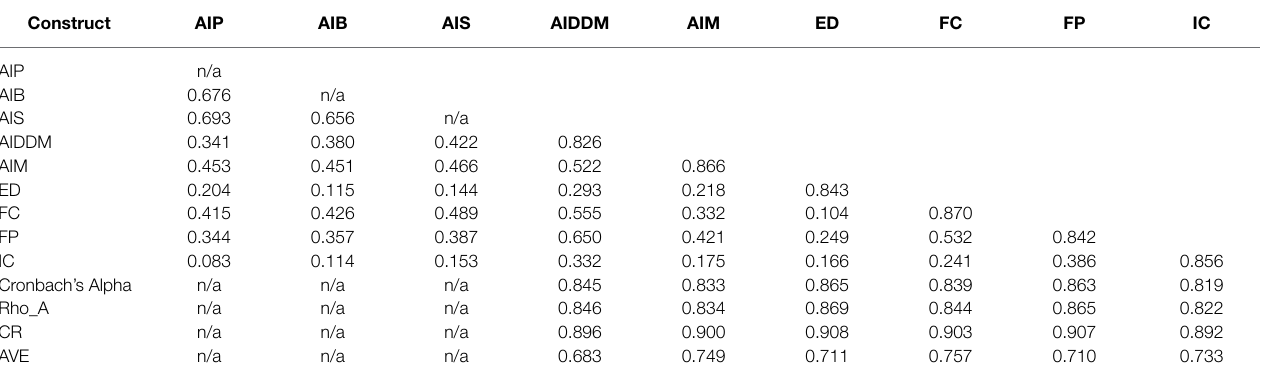
TABLE 4 | Reliability, convergent validity, and discriminant validity.